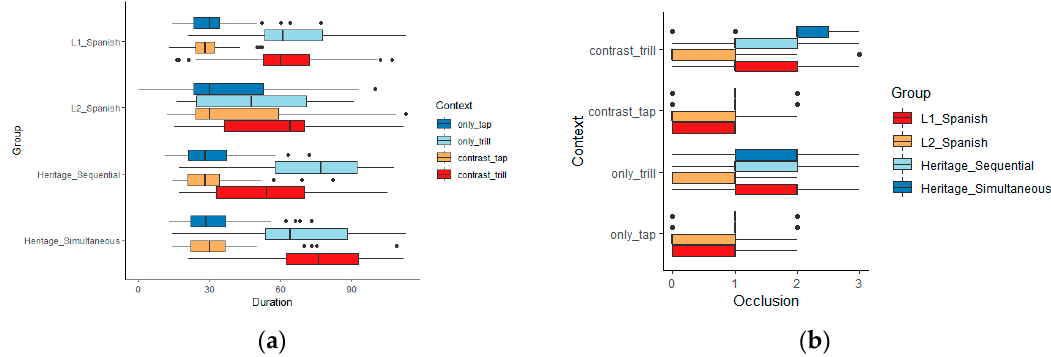
Figure 3. Boxplot for ( a ) duration (milliseconds) of the rhotic sounds according to participant group ( y -axis) and rhotic context (fill) and ( b ) number of apical occlusions according to rhotic context ( y -axis) and participant group (fill).